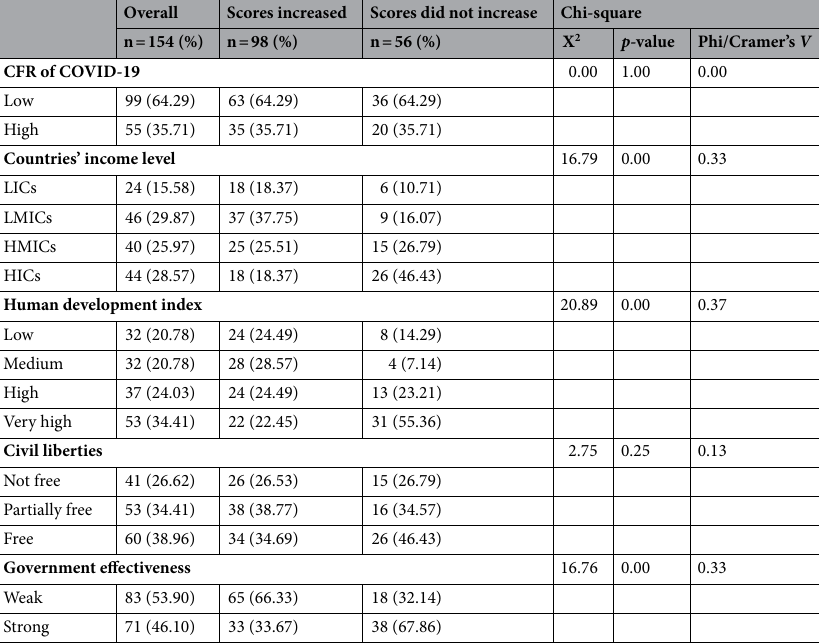
Table 1. Description of COVID-19 CFR, countries’ income level, HDI, CL, and GE among overall countries (group A), countries whose scores increased (group B) and not increased (group C). This table describes the COVID-19 CFR, countries’ income level, HDI, CL, and GE among overall countries (group A), countries whose scores increased (group B) and not increased (group C). Based on country income level, among the countries that experienced an increase in scores, the majority were lower-middle-income countries (LMICs) (37.75%), while the high-income countries (HICs) and low-income countries (LICs) were the least with 18.37% each. On the contrary, HICs were the majority among countries whose scores did not increase (46.43%). Similar to the distribution of income country level, countries with medium development status were the group that mostly (28.57%) experienced an increase in e-SPAR scores during the pandemic. Meanwhile, countries with very high development status were the majority in the group of countries whose scores did not increase (55.36%) in 2020 compared to the previous year. Next, for civil liberties status, most countries within the group of countries whose scores increased during the pandemic were “partially free” countries (38.77%), followed by “free” countries (34.69%), and the least was “not free” countries (26.53%). Meanwhile, among the countries whose scores did not increase during the pandemic, most of them were “free” countries (46.43%). Then, for government effectiveness, most of the countries whose scores increased during the pandemic had weak GE (66.33%) while most of the countries whose scores did not increase had a strong GE (67.86%). Meanwhile, for CFR of COVID-19, 64.29% of the countries in each group had low